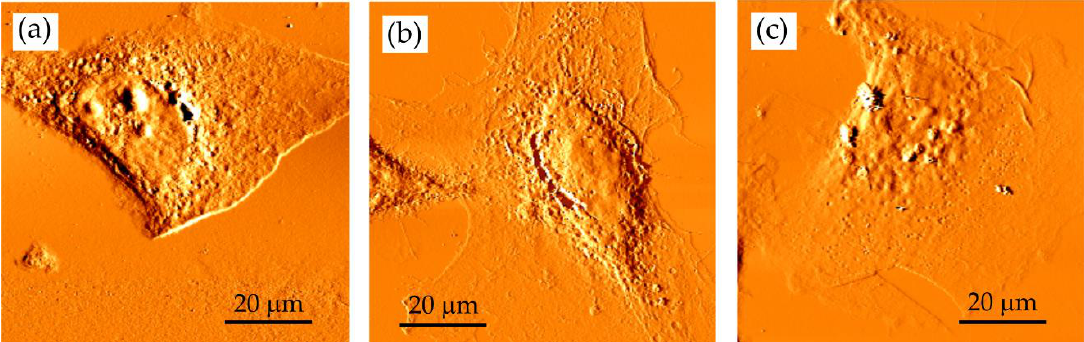
Figure 4. The developer concentration influences SXCM imaging. MIBK:IPA ratio: ( a ) 1:1; ( b ) 1:2 and ( c ) 1:3 (the development time was 4 min). AFM deflection images of fixed HCC38 cells recorded using Xe120 AFM (Park Systems) with OTR4 cantilevers (0.02 N/m, Bruker, Camarillo, CA, USA). Scan size of 80 × 80 µm 2 ; 600 SXR pulses.